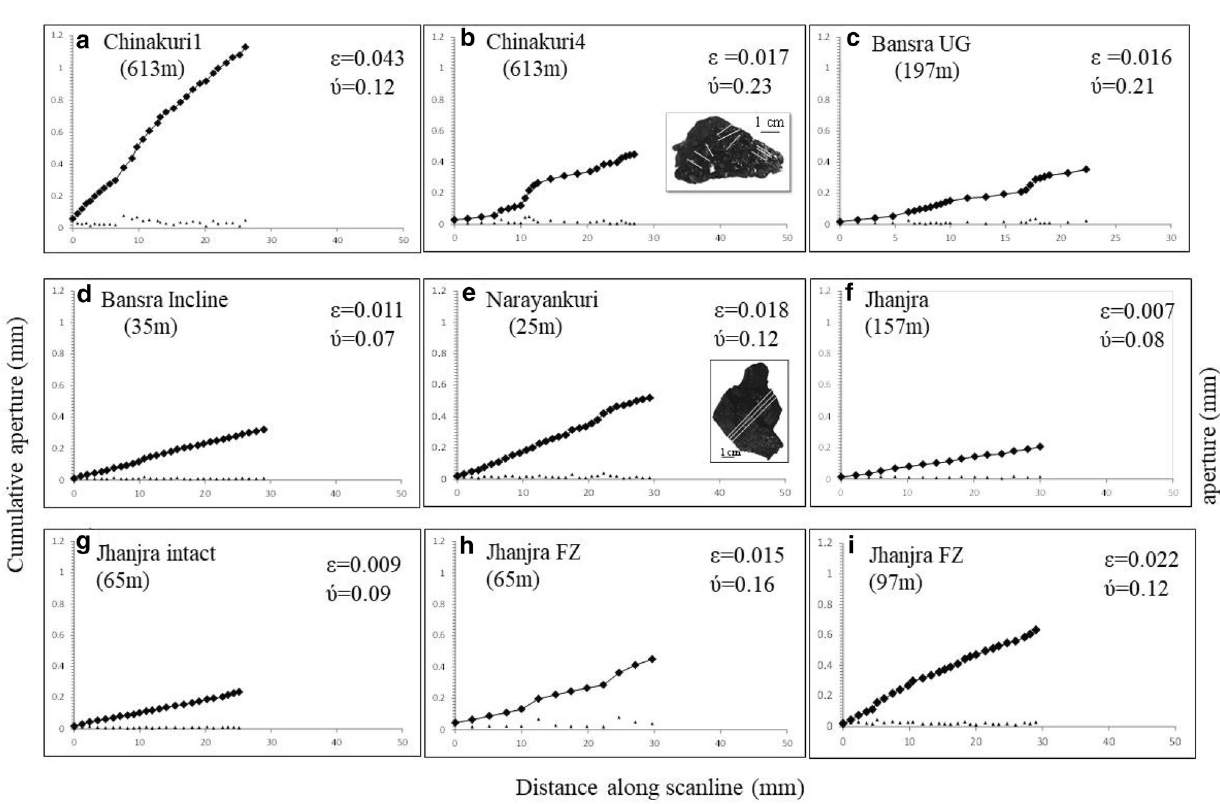
Fig. 6 Cumulative cleat aperture along scanlines from one sample of each of the four locations as outlined in Fig. 3. The solid rectangles on these plots show the cumulative frequencies and the solid triangles represent individual aperture measurements. Sampling depths, the strain ( e ) and variability ( t 9 ) along the scanline are labelled on each plot suggesting the effect of faults (FZ: sample collected within 1m of fault zone) is more on the variability than their depth of occurrence and strain. The inset figures in ( b ) and ( e ) are examples of highly variable and almost uniform cleat patterns